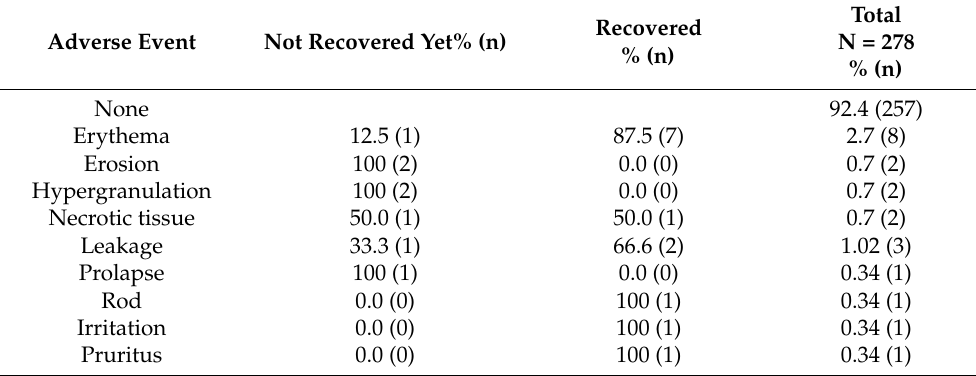
Table 6. Evaluation of peristomal skin improvement in all patients according to the type of device and some characteristics.